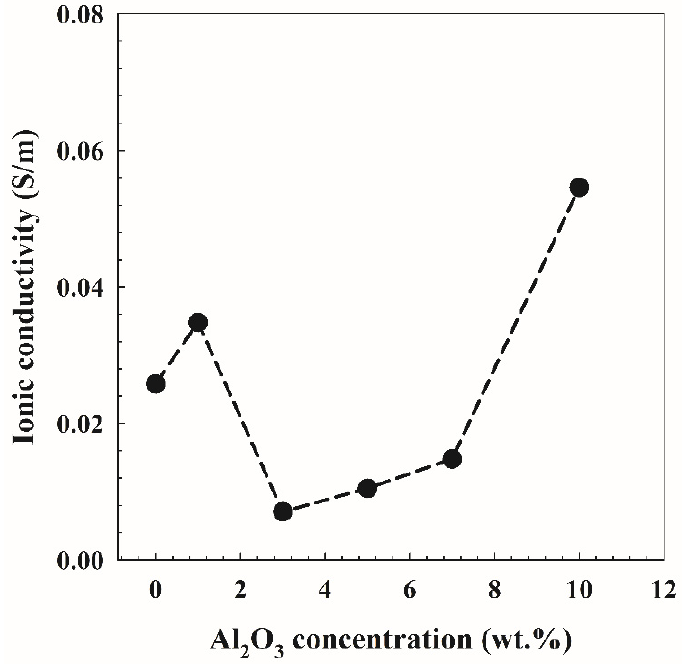
Figure 7. Ionic conductivity as a function of Al 2 O 3 concentration on PVA/10 wt.% PEG polymers.